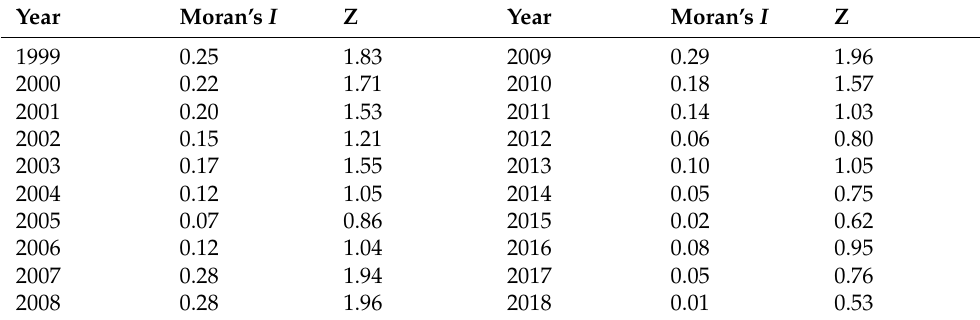
Table 7. Global Moran’s I index and Z value of the coupling system in 11 provinces from 1999 to